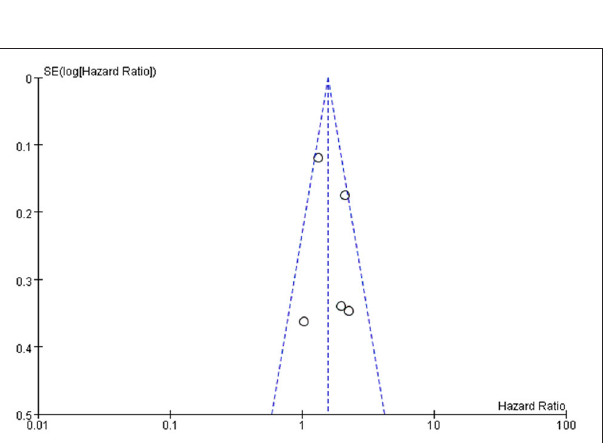
FIGURE 3 | Funnel plot of frailty and overall